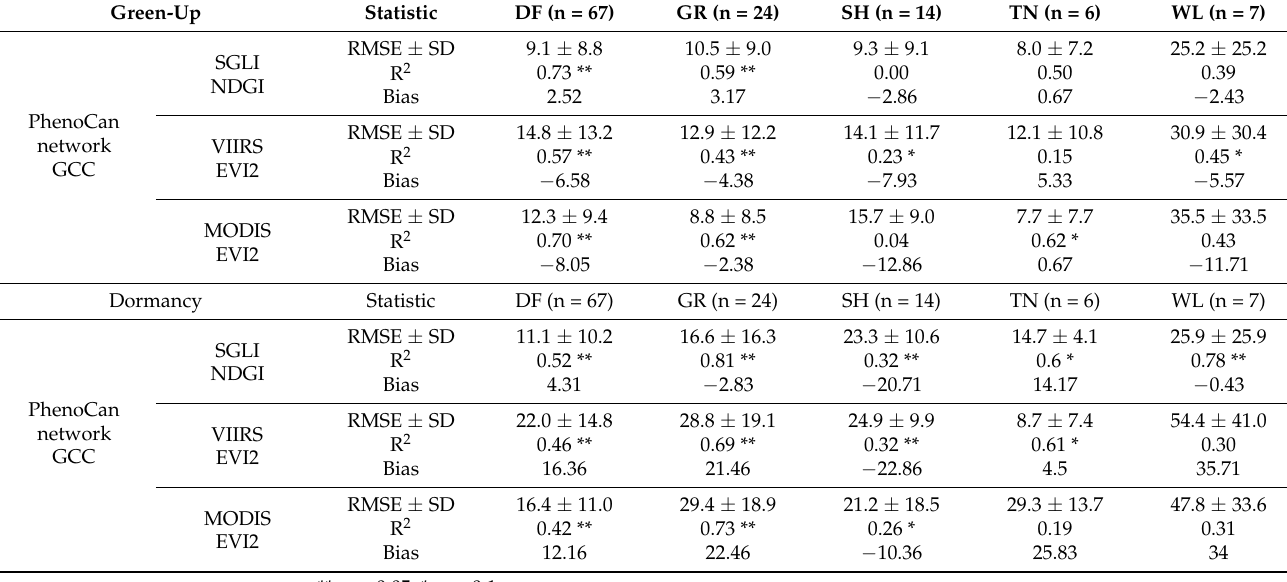
Table 2. Statistical comparison of green-up and dormancy dates from SGLI, VIIRS, and MODIS with those from near-surface phenology observations (PhenoCan network) in 115 sites by vegetation types (DF: deciduous forest; GR: grassland, SH: shrub; TN: tundra; WL: wetland). Green-up and dormancy dates from VIIRS and MODIS extracted from those phenology products (MCD12Q2 and VNP22Q2).